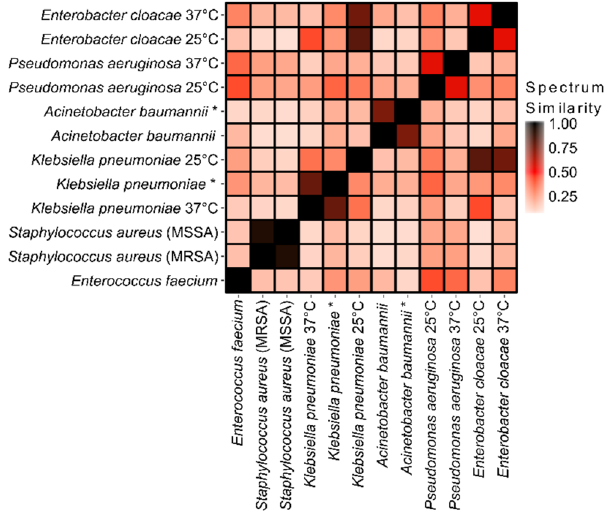
Figure 3. Dot product analysis of mass spectra for differentiation of ESKAPE pathogens. Mass spectra were acquired from lipid extracts of each ESKAPE pathogen. Species were compared by calculating a pairwise dot product between mass lists of ions from each mass spectrum, a measure of spectrum similarity. A similarity score of 1.0 is an identical match (black squares). White squares represent a score of 0.0 where there is no match. ( * ) indicate colistin-resistant